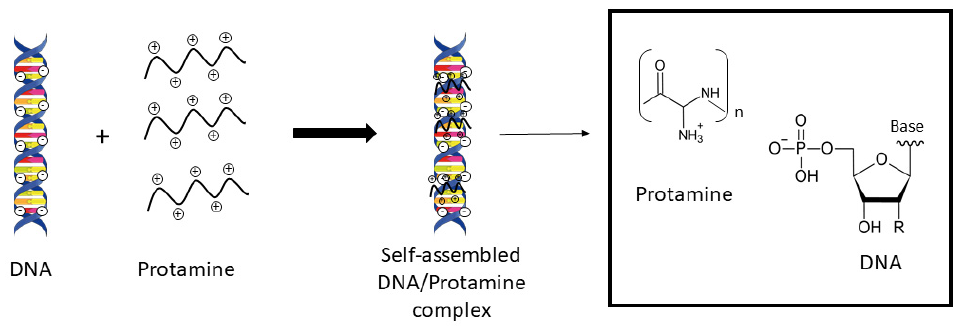
Figure 3. Scheme of self-assembling process between the positively charged Protamine and DNA as negatively charged ODN component. Electrostatic interactions provoked by Protamine’s cationic amino acid groups and the negative phosphate backbone of the ODN result in a self-assembled ODN/Protamine complex.